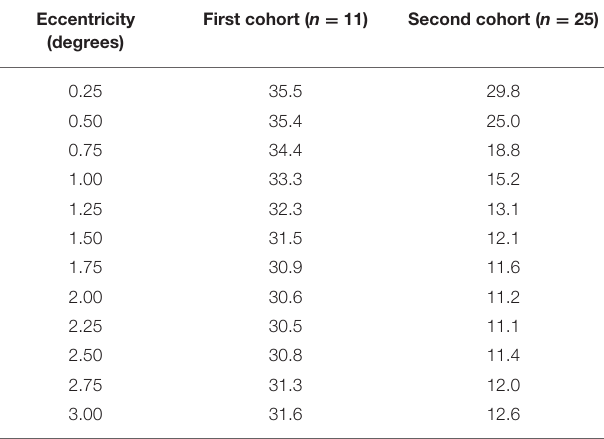
TABLE 1 | Variability of pixel intensity at increasing macular eccentricities. Eccentricity (degrees)